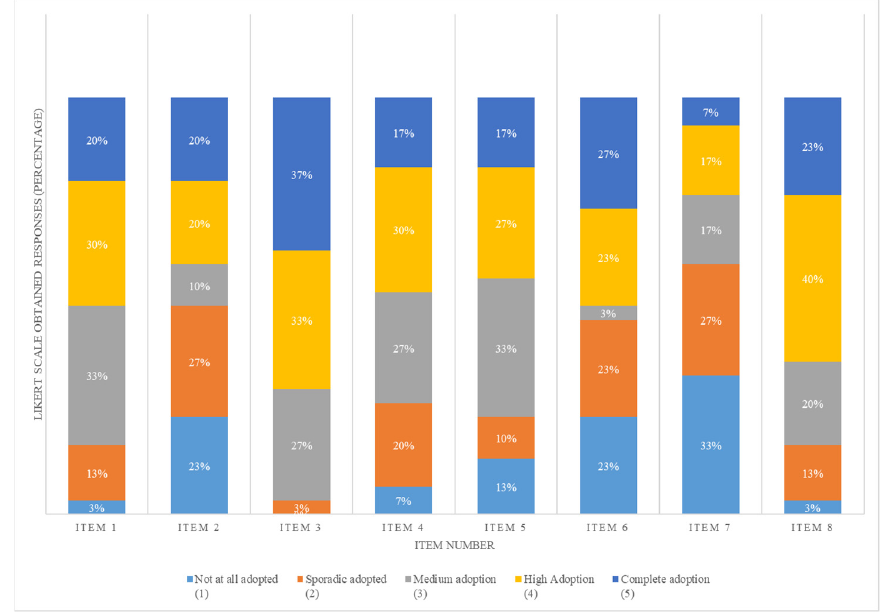
Figure 5. Adoption and efficiency of anti-COVID-19 measures response obtained.